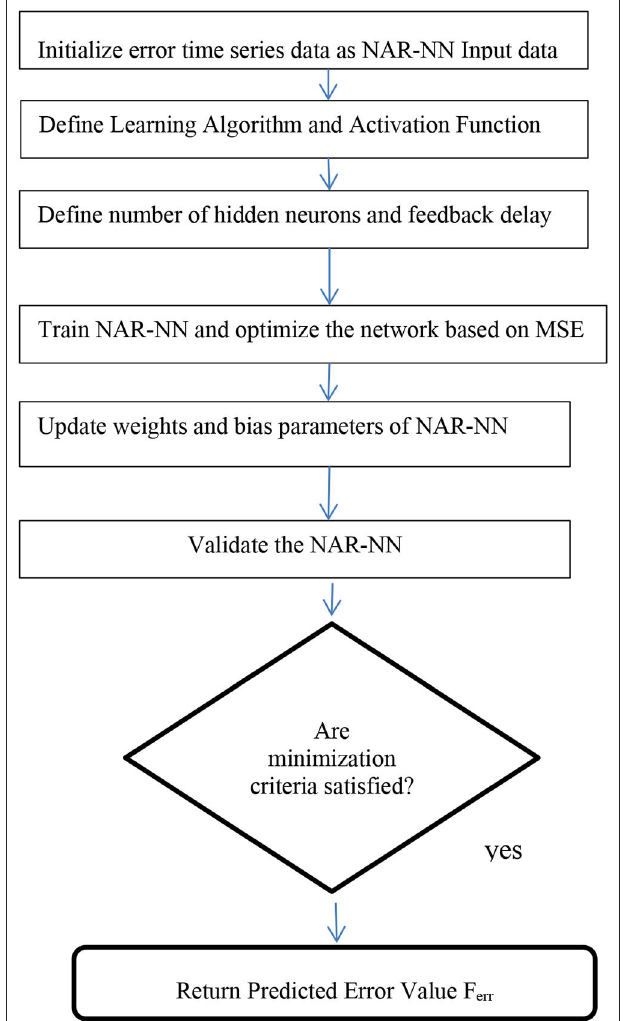
FIGURE 2 | Workflow of NAR-NN time series forecasting.